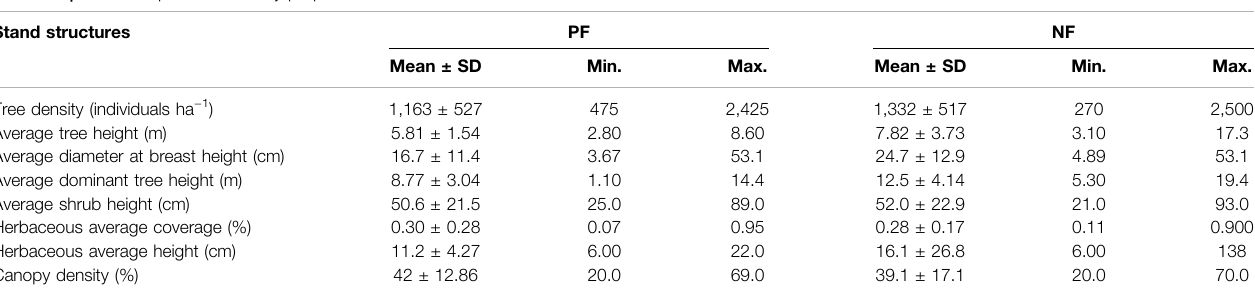
TABLE 1 | The basic plant community properties of the PF and NF in the forest farms of Qilian Mountains. Stand structures PF NF Mean ± SD Min. Max. Mean ± SD Min.